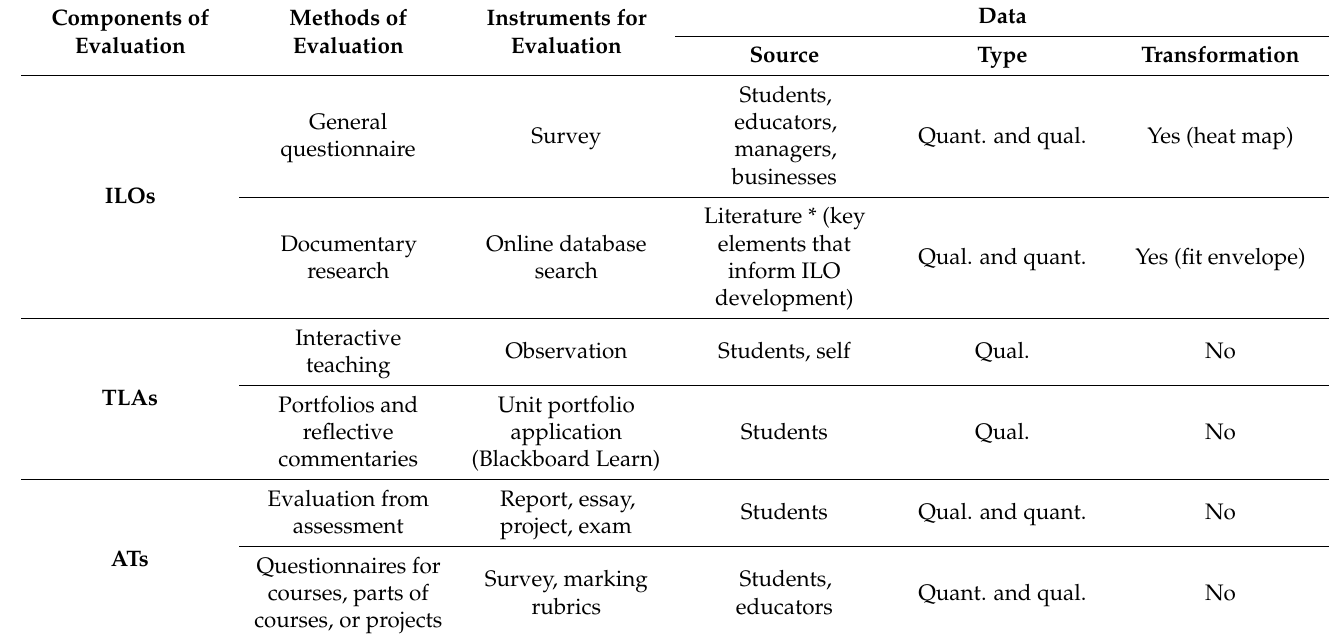
Table 4. Mixed evaluation methods